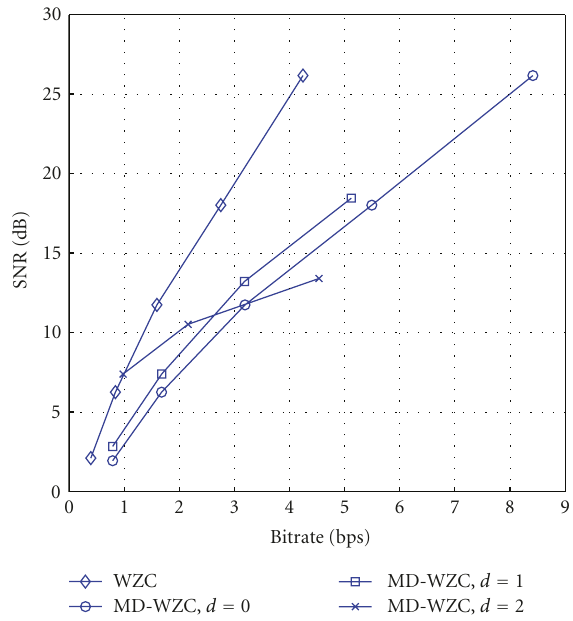
Figure 12: Side rate-distortion comparison of the MD-WZC schemes for a CSNR value of 10